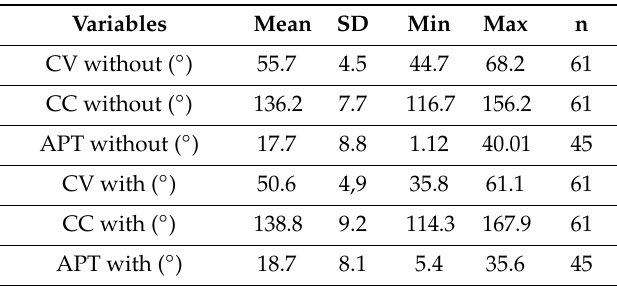
Table 2. Postural angles without and with schoolbag.